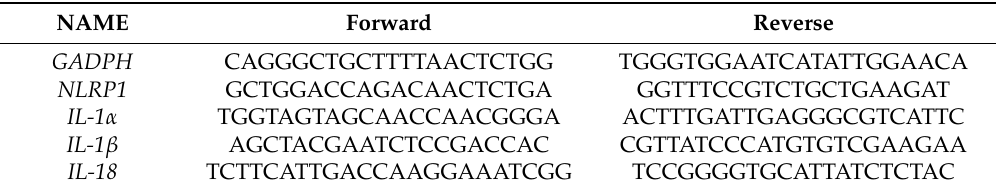
Table 1. The primers used in quantitative RT-PCR. GADPH and NLRP1 were obtained